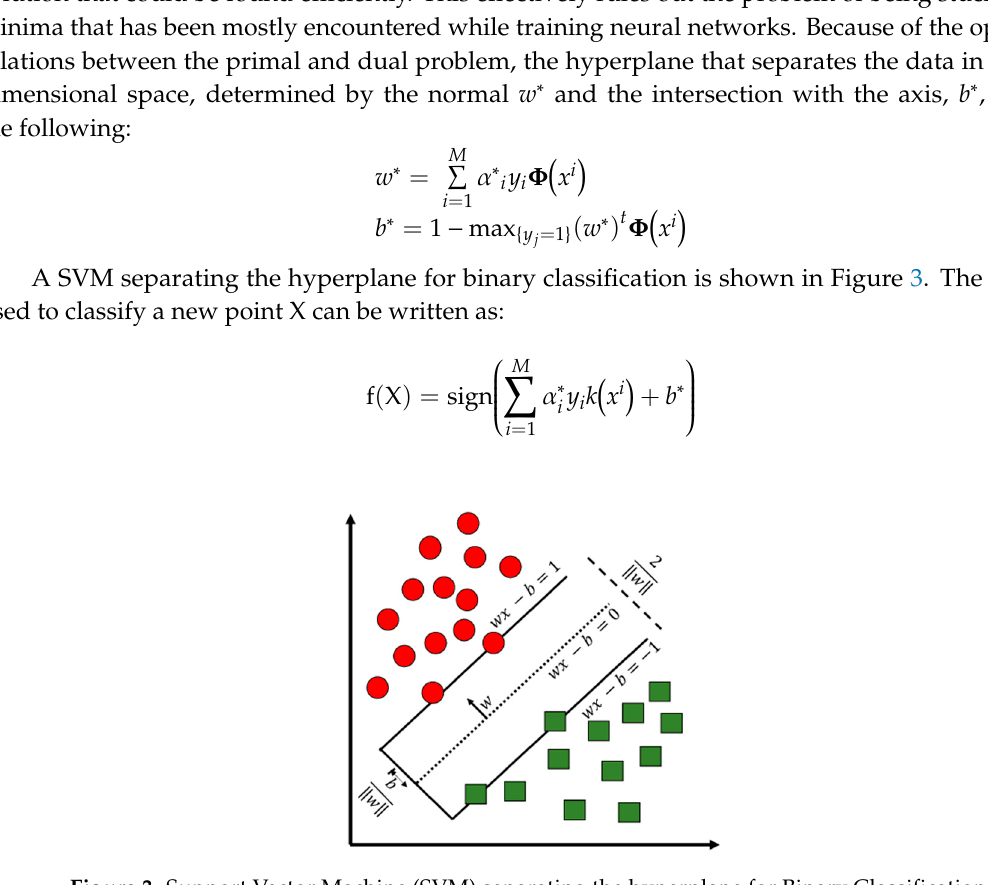
Figure 3. Support Vector Machine (SVM) separating the hyperplane for Binary Classification.